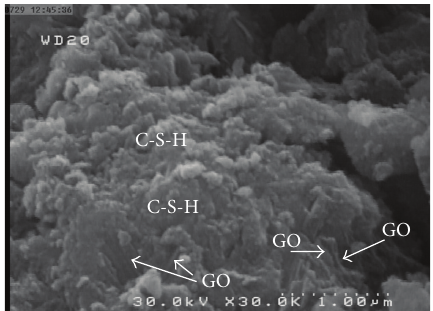
Figure 9: The Mechanism of steric repulsion of comb polymer in dispersion [6].